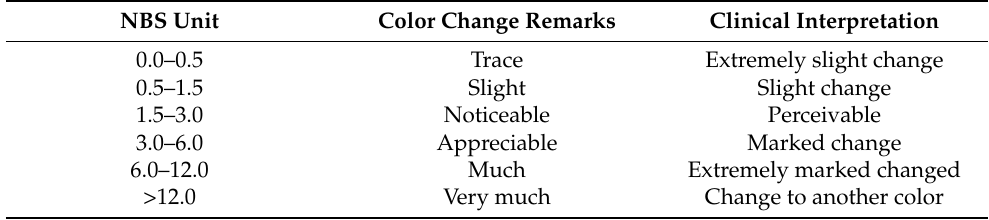
Table 1. NBS interpretation of ∆